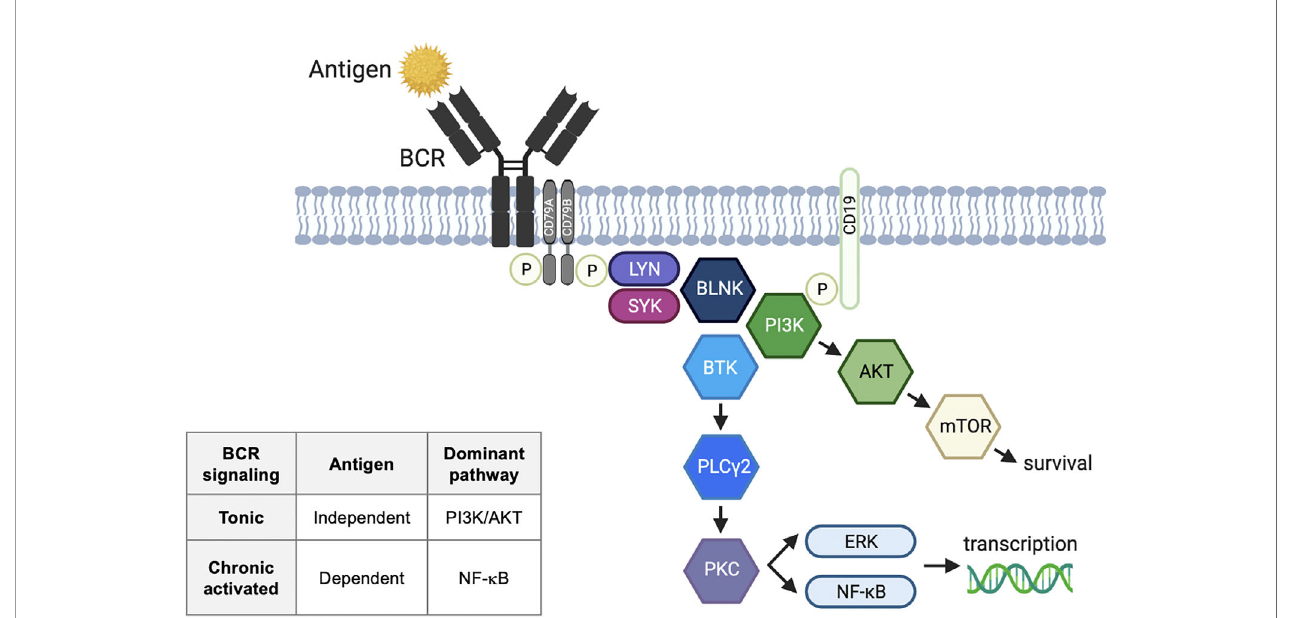
FIGURE 1 | B cell receptor signaling pathway. Activated B cell receptor (BCR) signaling is an antigen-dependent process utilizing the canonical nuclear factor- k B (NF- k B) pathway. Antigen binding by surface immunoglobulin initiates BCR signaling, resulting in coupling and autophosphorylation of the CD79A/CD79B heterodimer by Src family kinases. The phosphorylation of the immunoreceptor tyrosine-based activation motifs recruits a cascade of signaling molecules. These include LYN tyrosine kinase (LYN), spleen tyrosine kinase (SYK), Bruton ’ s tyrosine kinase (BTK), phospholipase C g 2 (PLC g 2), and protein kinase C (PKC), which lead to activation of NF- k B, phosphatidylinositol 3-kinase (PI3K) and ERK. Tonic BCR is an antigen-independent process that maintains B cell survival through PI3K-AKT- mTOR signaling rather than NF- k B. BLNK, B-cell linker; ERK, extracellular signal-regulated kinase; IgH, immunoglobulin heavy chain; IgL, immunoglobulin light chain; mTOR, mammalian target of rapamycin; P,